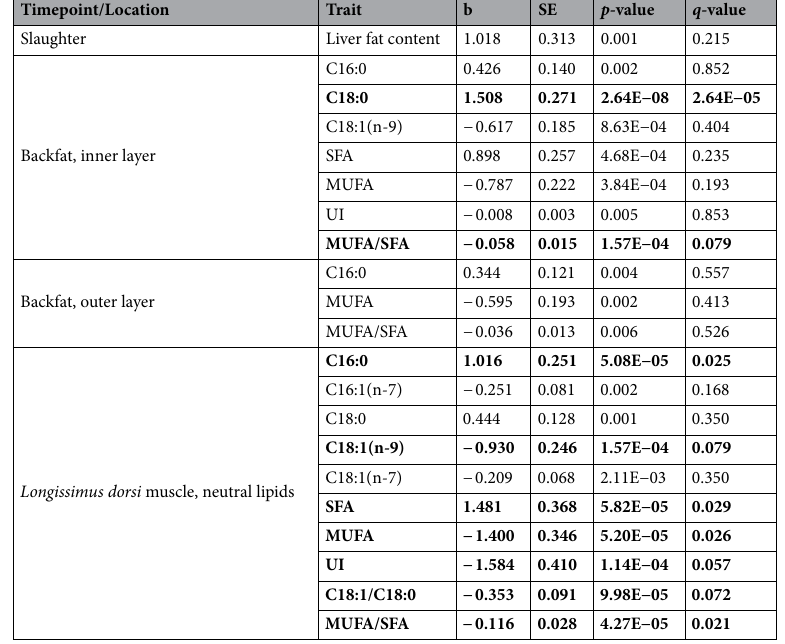
Table 6. Association results for polymorphism in gene NLE1 (168_NLE1, position 40,037,354). Traits with p‑ value < 0.01 are shown and those with q < 0.10 are highlighted in